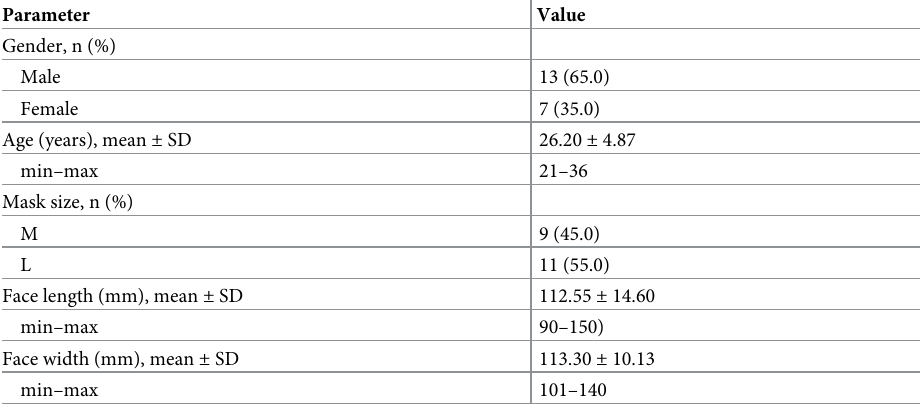
Table 4. General characteristics of participants (n =